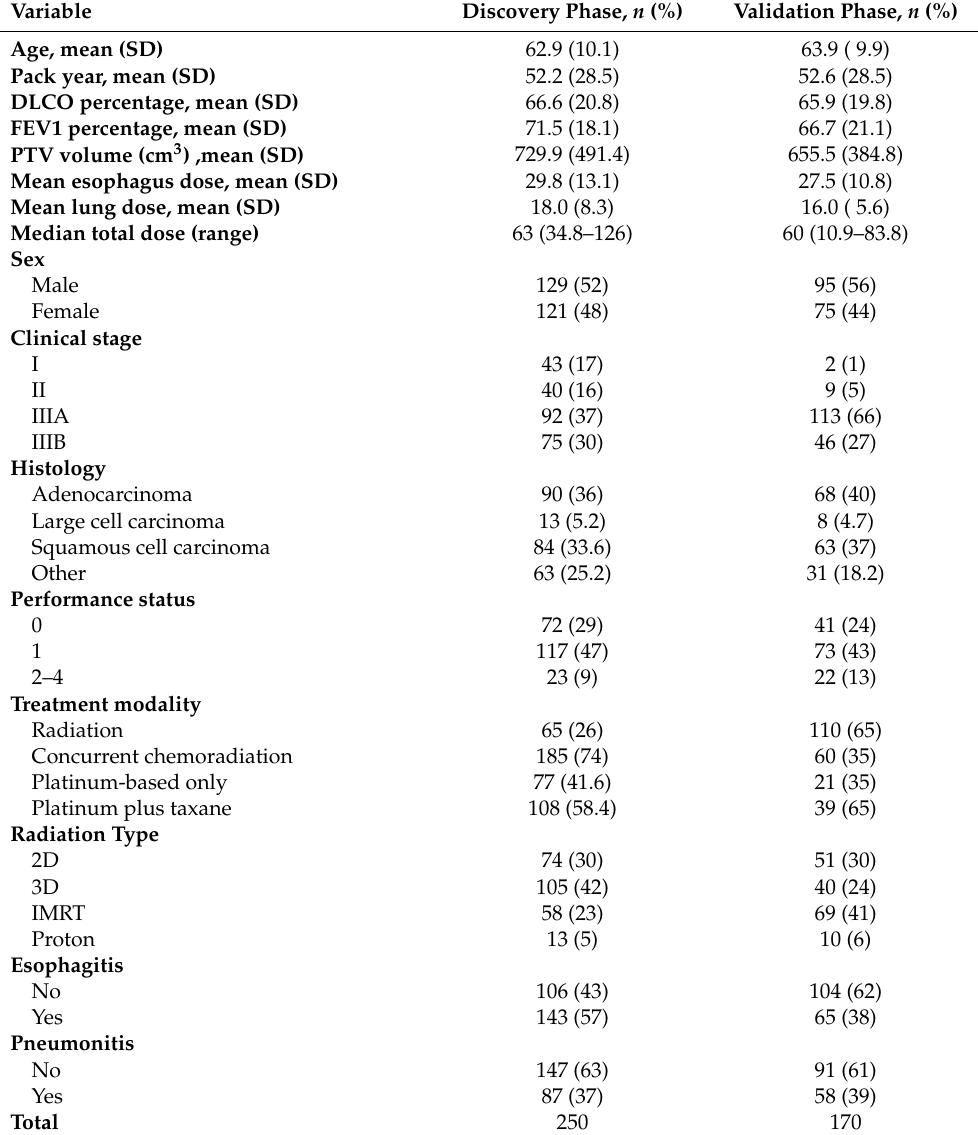
Table 1. Patient